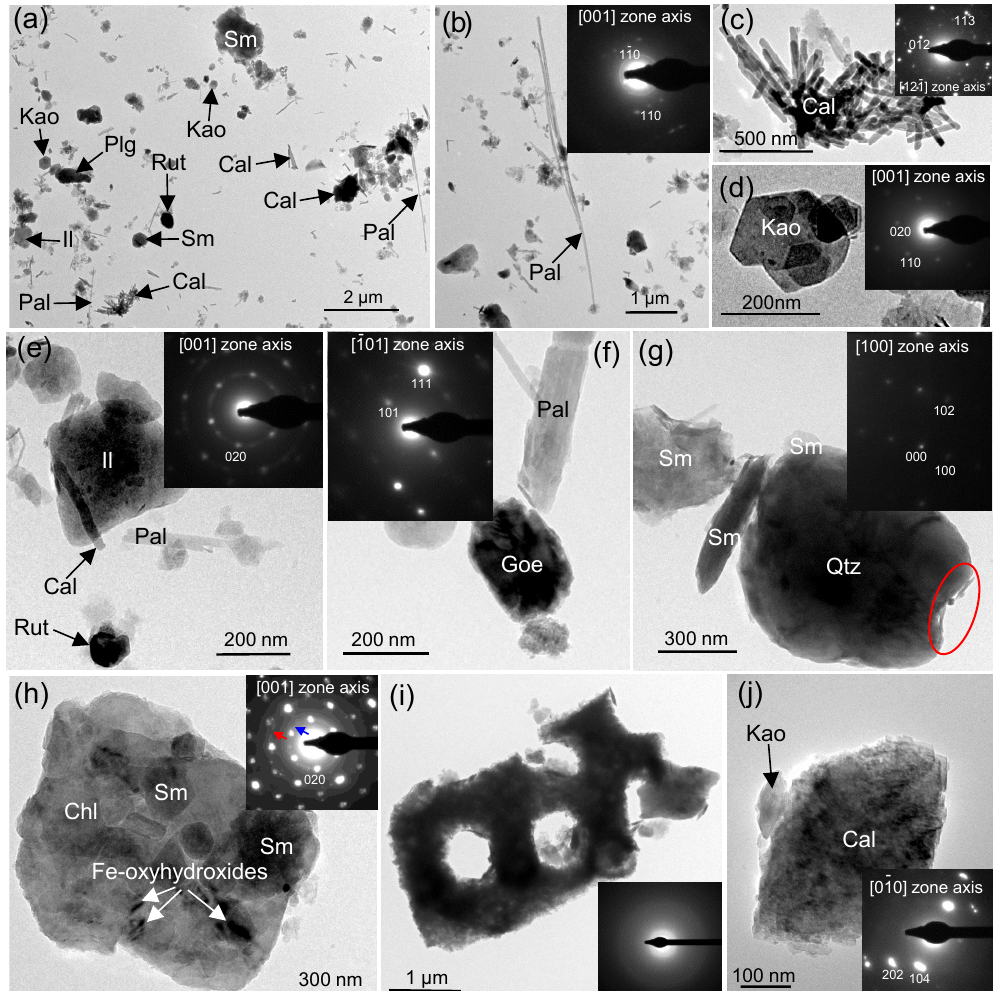
Figure 6. TEM photomicrographs of Saharan dust particles. (a) General low-magnification overview of the particles. Note the abundance of fibrous particles. The long ones are palygorskite (Pal), while the short ones ( ∼ 0.5µm) are calcite (Cal). The larger particles or aggregates corresponds to feldspars (plagioclase, Plg), illite (Il) and smectites (Sm). The smaller particles include kaolinite (Kao) and rutile (Rut). (b) Detail of elongated palygorskite fiber. The [001] zone axis SAED pattern is shown in inset. (c) Aggregate of fibrous calcite (SAED pattern in inset). (d) Plate-like kaolinite particles (SAED pattern in inset). (e) Illite (SAED in inset), rutile, palygorskite and fibrous calcite. (f) Goethite (Goe) (SAED pattern in inset) and palygorskite. (g) Quartz (Qtz) grain (SAED in inset) surrounded by smectites (Sm). The red circled area shows clay minerals plus iron oxyhydroxide nanoparticles forming a rim around the quartz grain. (h) Chlorite (Chl) (SAED in inset) with adhered smectite and iron oxyhydroxide nanoparticles. The blue and the red arrows in the SAED pattern show the diffuse Debye rings corresponding to the reflections with d -spacing 4.49 and 2.5Å, respectively (see the discussion in the main text). (i) Amorphous silica structure (diffuse haloes in SAED pattern in inset). This is part of the skeleton of a diatom. (j) Rhombohedral calcite crystal (SAED in inset) surrounded by